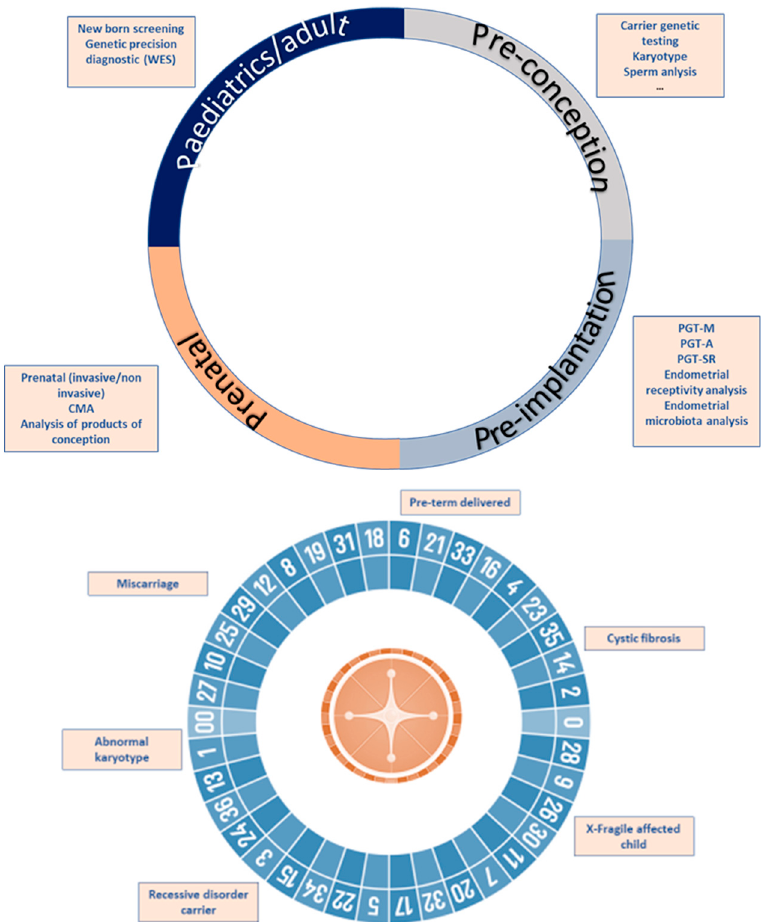
Figure 1. Reproductive journey vs. reproductive roulette: Genetic analysis can be implemented at any stage of the reproductive journey, starting from preconception to detect genetic carriers of frequent diseases, pre-implantation to ensure chromosomal and genetically normal embryos, prenatal diagnosis and lastly, for newborn screening of common and actionable diseases. The reproductive roulette is a term that aims to explain the unknown risk of having any form of genetic disease given the risk factors of the parents or purely by chance. The possibility of reducing this probability can be done by an adequate and directed genetic analysis or screening approaches.